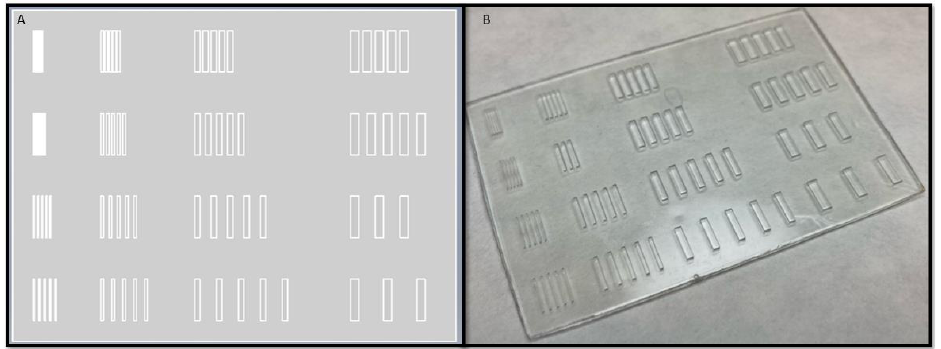
Figure 5. ( A ) Figure of the parametric design made with Inventor from Autodesk. ( B ) Picture of one of the 3D printed piece obtained, for the design of 600 µm height and the resin from Asiga.